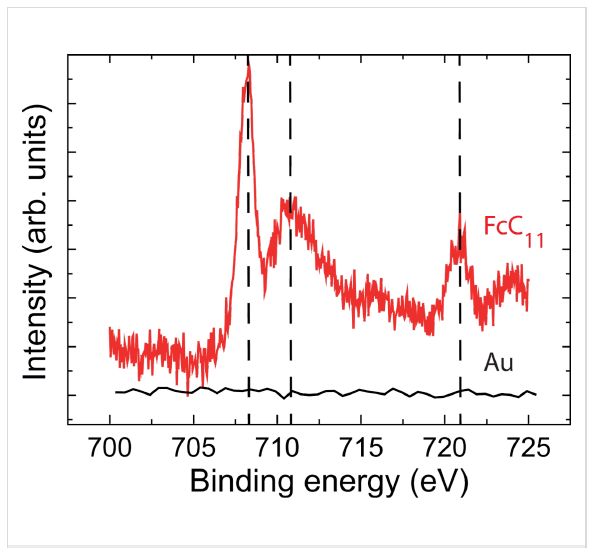
Figure 4: Fe 2p XPS spectra corresponding to the bare Au nanoarray and 11-ferrocenyl-1-undecanethiol (FcC 11 ) SAM from bottom to top.